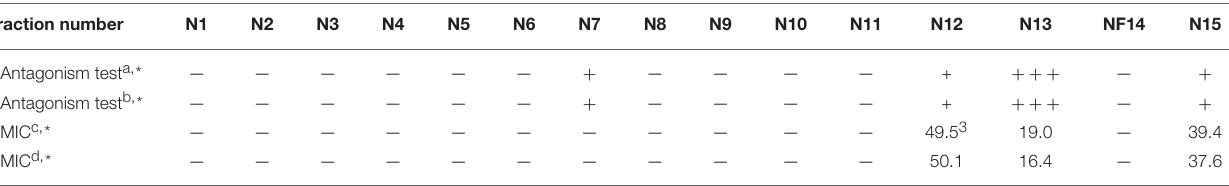
TABLE 2 | Relative antibacterial activity of each fraction in the culture filtrate from Ln. mesenteroides LBP-K06. Fraction